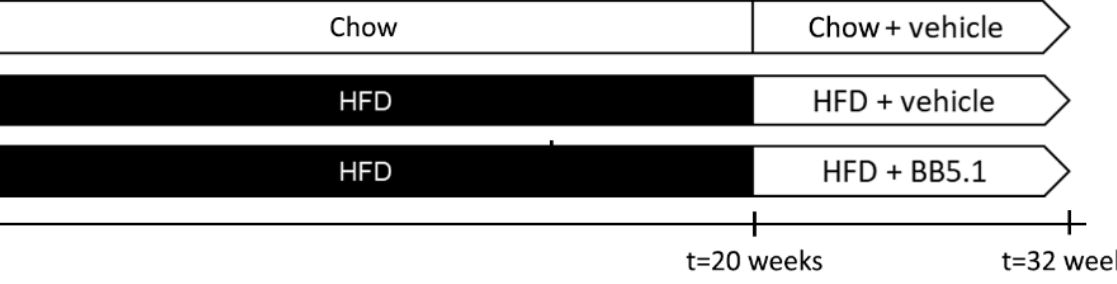
Figure 1. Experimental design. All mice were fed a standard chow diet until the start of the study. At the start of the study (t = 0 weeks), one group (Chow, n = 8) remained on the standardized chow diet as a healthy reference and the other two groups (HFD+vehicle, n = 17 and HFD+BB5.1, n = 17) were fed a well-established obesity-inducing energy-dense HFD. Twice a week, from t = 20 weeks until the end of the study (t = 32 weeks), Chow and HFD+vehicle animals received 200- µ L intraperitoneal injections of PBS, while HFD+BB5.1 received 200- µ L intraperitoneal injections of BB5.1 anti- C5 antibody (1 mg/mouse in PBS).